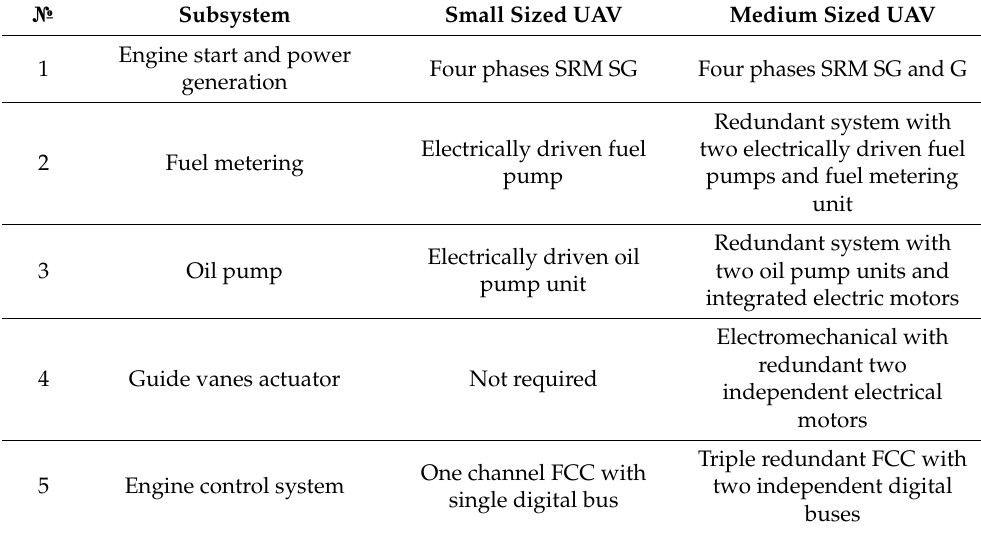
Table 2. Proposed features of a distributed system for more electric engines of small and middle sized